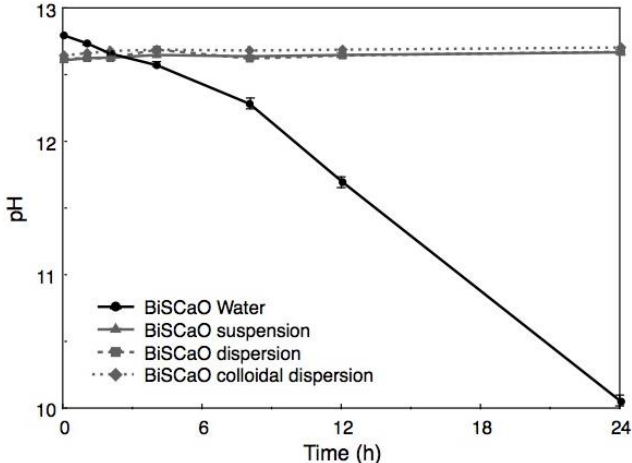
Figure 3. Changes of pH in BiSCaO Water during stirring in open air. When BiSCaO Water with strong alkalinity (pH 12.8) was exposed to air with stirring, the pH decreased to approximately 10 after 24 h. On the other hand, the pH in a BiSCaO suspension, dispersion, and colloidal dispersion did not change appreciably during 24 h of stirring in open air. Values are plotted as mean ± SD ( n = 4).